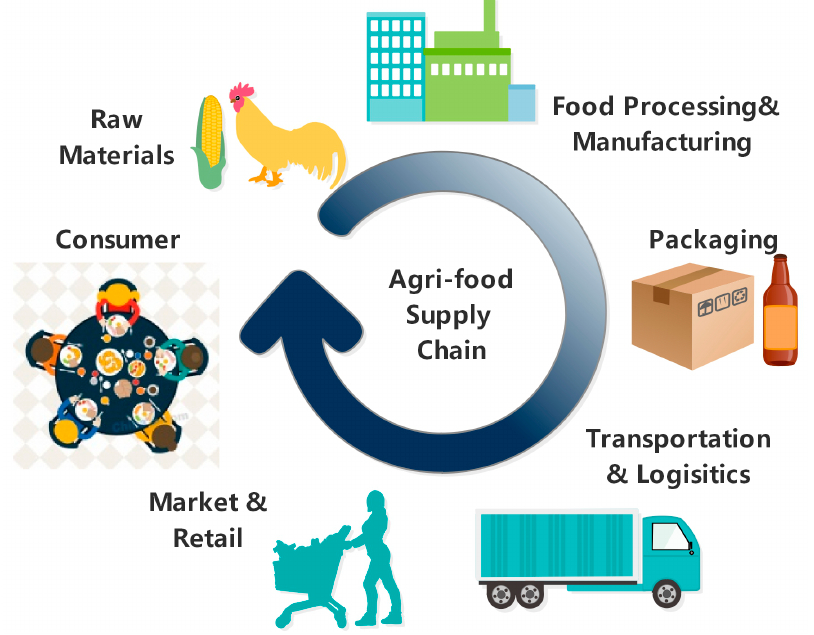
Figure 6. Schematic representation of the Agri-food supply chain from the grower to consumer.